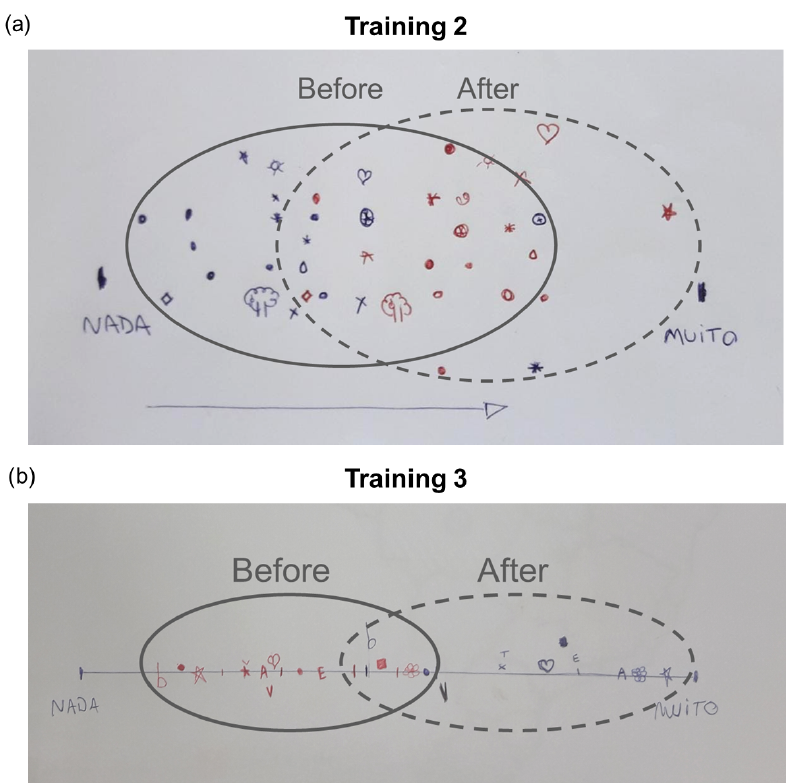
Figure 8. Charts illustrating the participants’ knowledge levels before and after training sessions for (a) training 2 and (b) training 3. Each symbol corresponds to a participant. The scale ranges from “nothing” (left side) to “a lot” (right side). The circle with a continuous line encompasses the self-rated scores before the training sessions, whereas the circle with a dashed line embraces the self-rated scores after the training